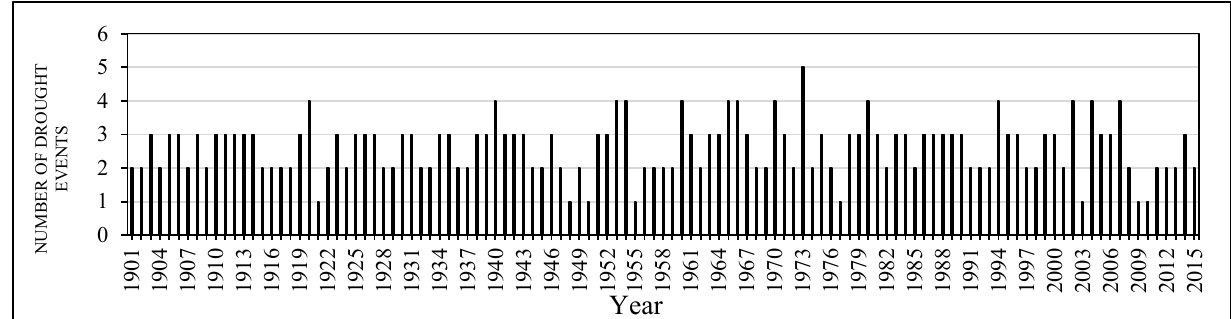
Figure 3.Graph Showing Number of Drought Occurred in Grid Number 164 (18.83N,76.108E)